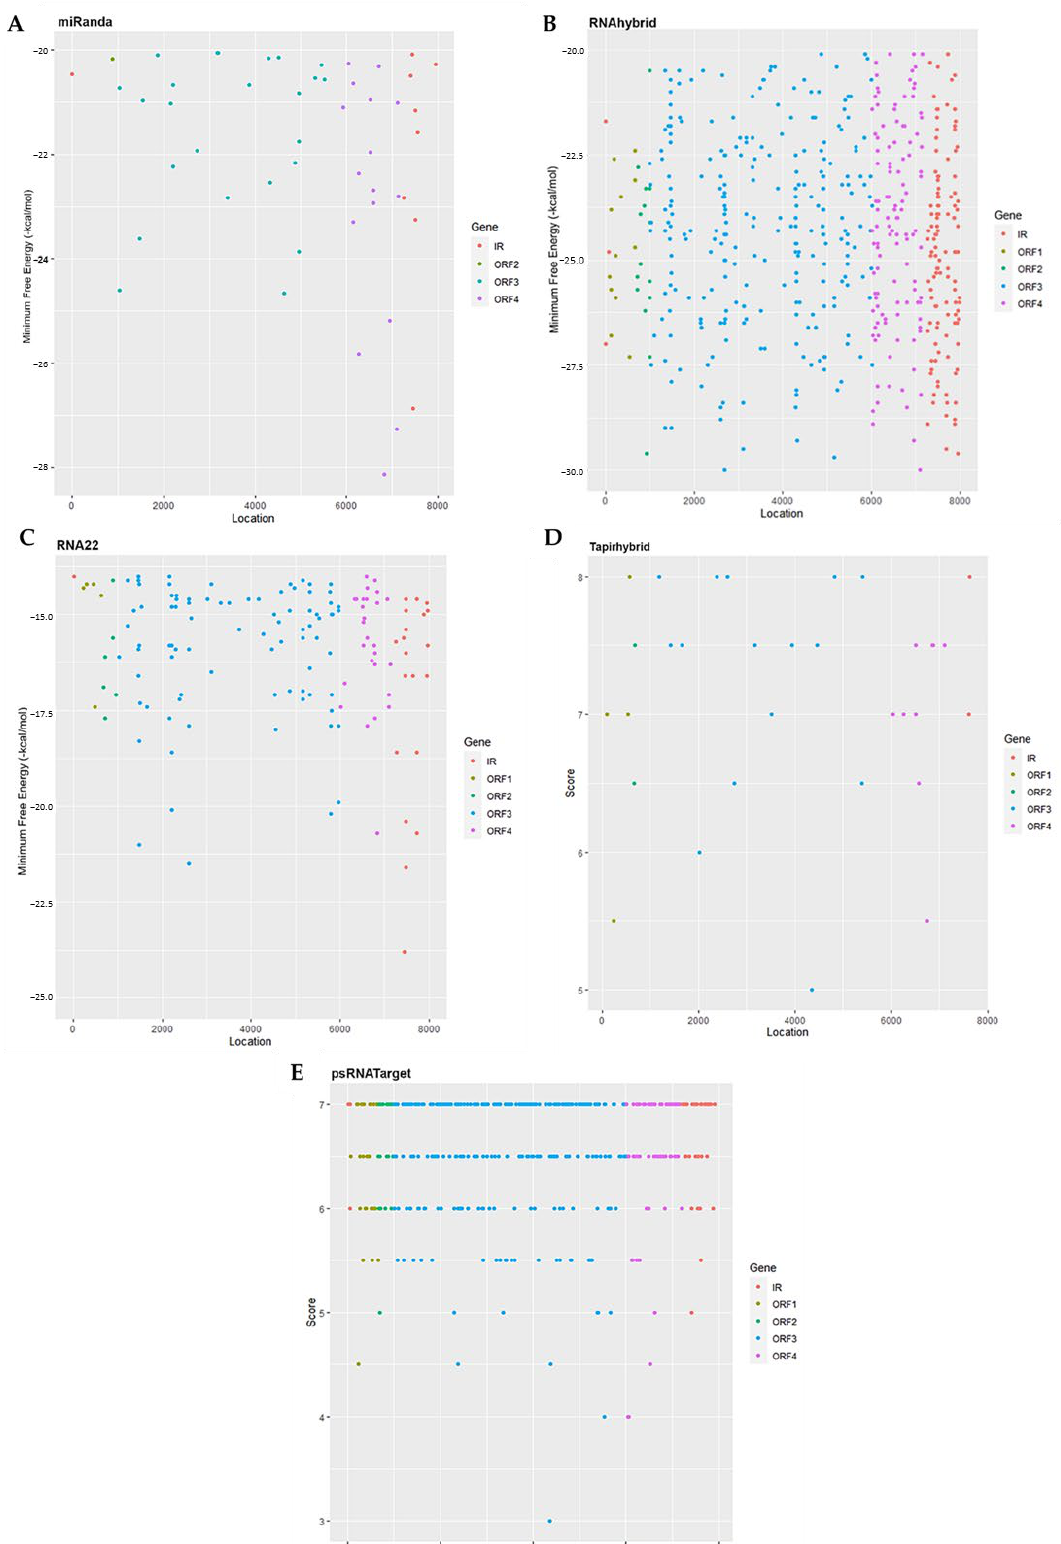
Figure 3. miRNA target site prediction outcome of rice’s miRNA on the RTBV’s genome sequence using the algorithms of miRanda ( A ), RNAhybrid ( B ), RNA22 ( C ), Tapirhybrid ( D ), psRNATarget ( E ). The colour key represents the respective regions in the genome. IR indicate intergenic region.